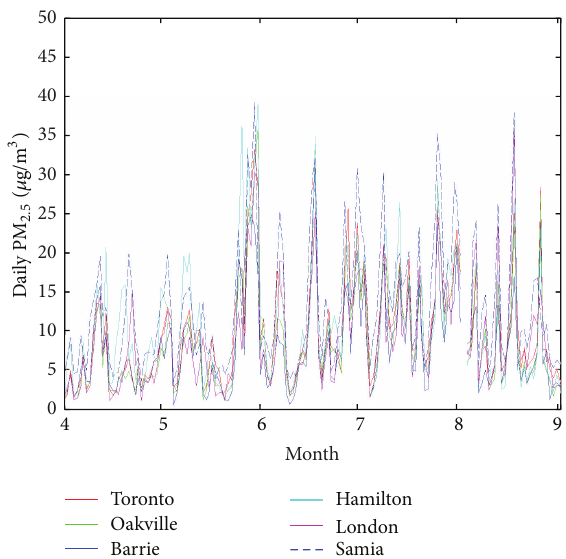
Figure 5: Daily PM 2.5 at Toronto and five cities where PM 2.5 values are highly correlated with that at Toronto (see Table 2) from April to September